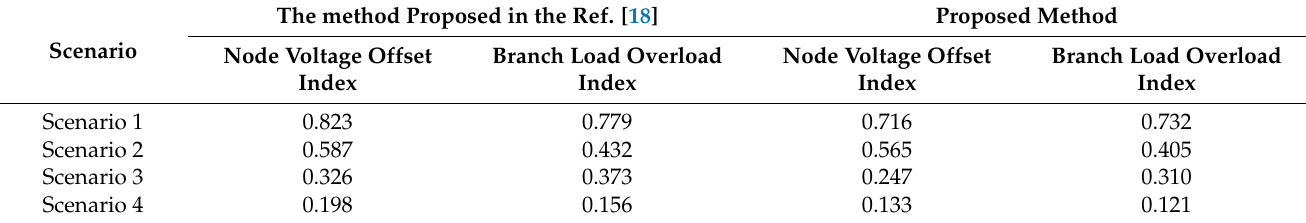
Figure 5. Branch load rate under different distributed power penetration. Table 2. Comparison of the influence of different access methods on the distribution